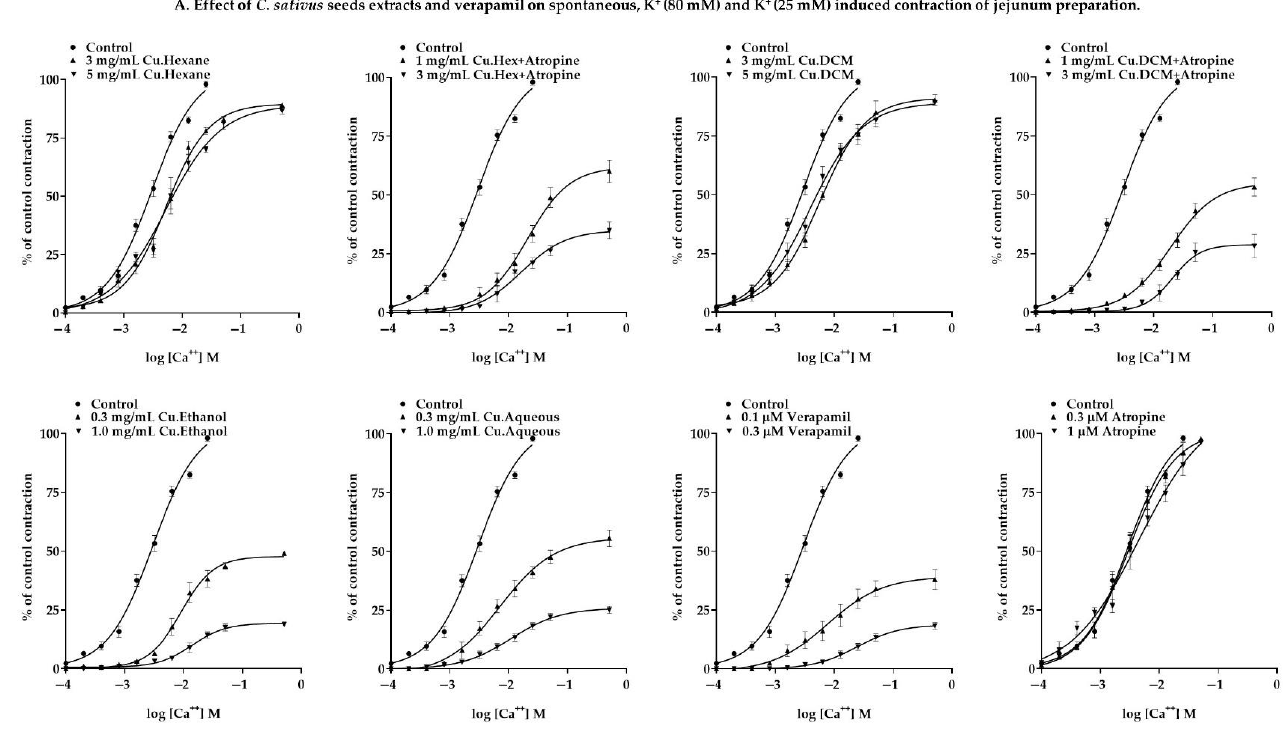
Figure 6. ( A ) Effect of C. sativus seed extracts and verapamil on jejunal preparations on spontaneous rhythmic contractions and spastic contractions of K + (80 mM) and K + (25 mM); ( B ) Calcium concentration – response curves on jejunum preparation in the presence and absence of C. sativus seed extracts and verapamil. Values are expressed as the mean ± SD ( n = 4), and data were evaluated using dose – response curves.